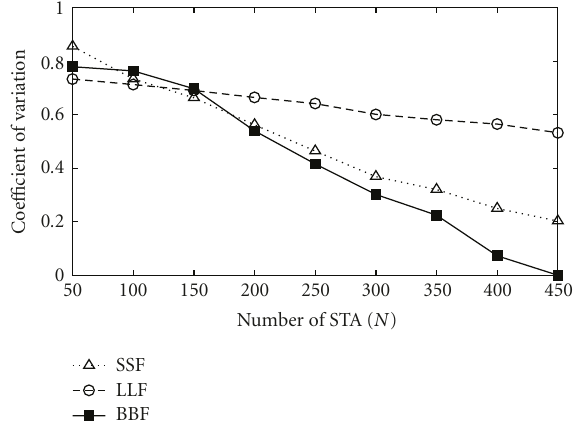
Figure 15: CV of AP’s tra ffi c